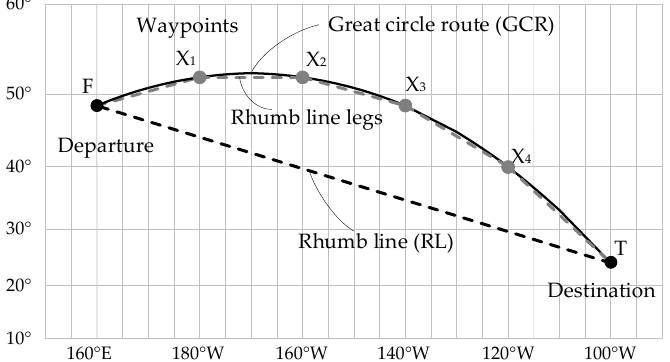
Figure 1. Schematic diagram of the great circle route (GCR) and rhumb line (RL).